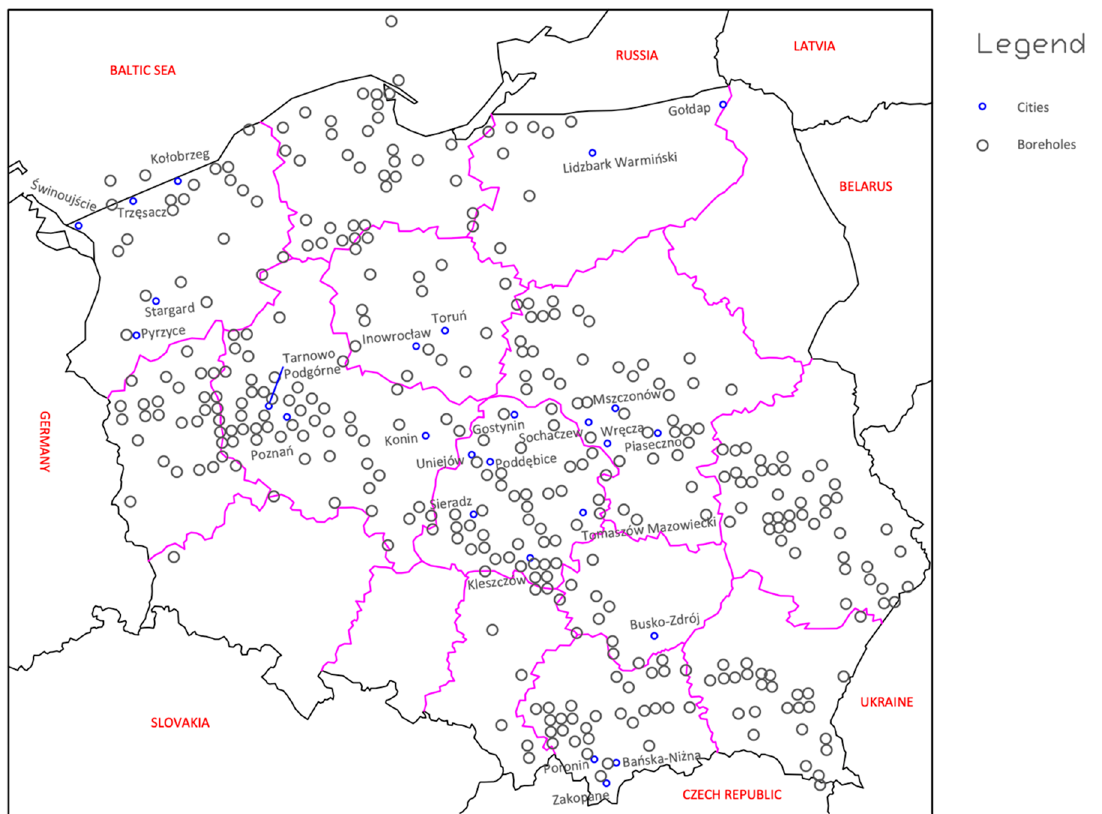
Figure 1. Research boreholes made in Poland with a depth of over 2500 meters below ground level, based on [29].